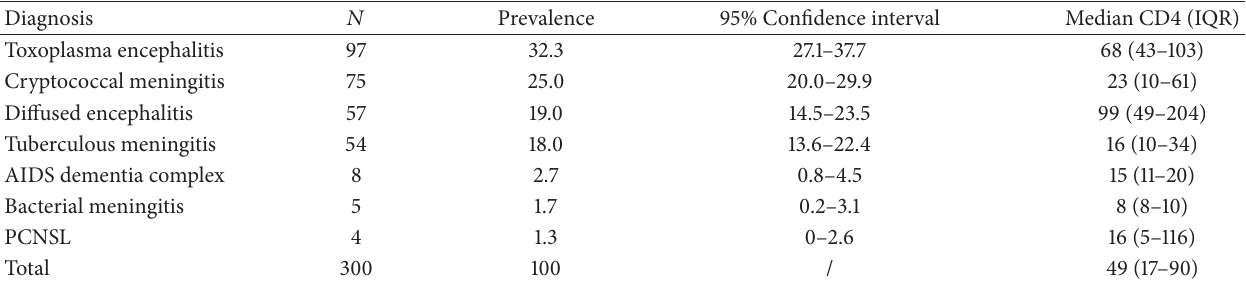
Table 3: Prevalence of the different aetiologies of CNS disease and the median CD4 cell count of 300HIV positive patients.